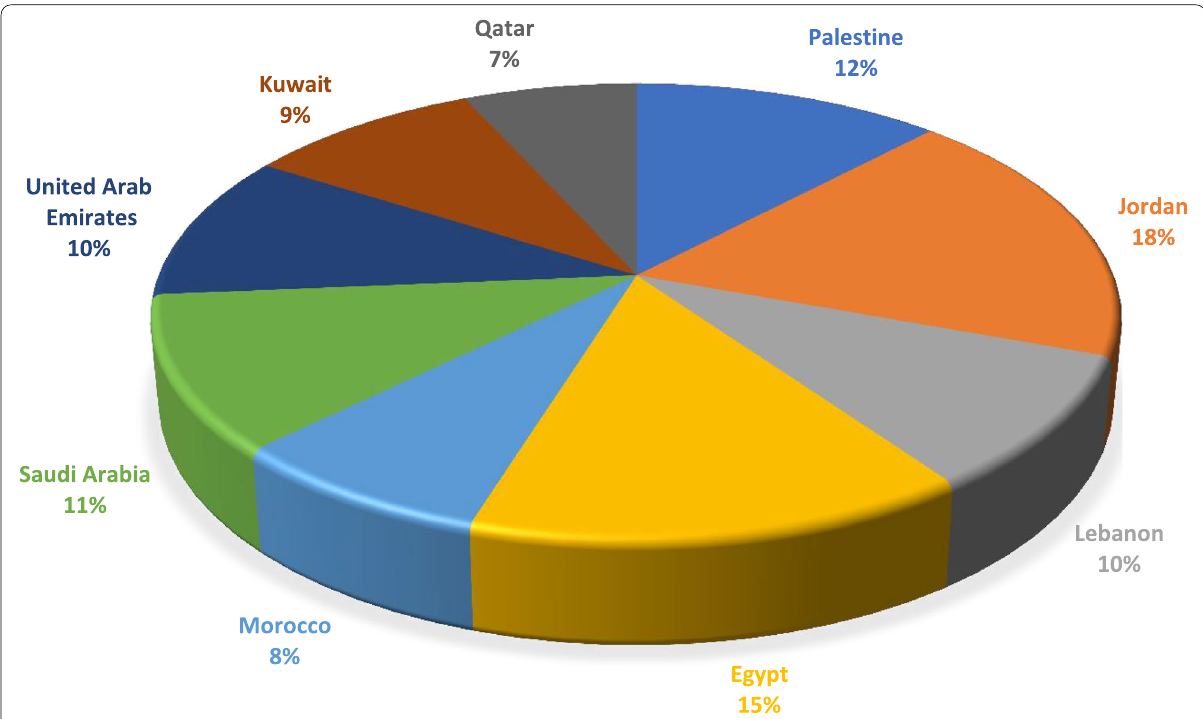
Fig. 1 Arab countries of healthcare professionals participated in this